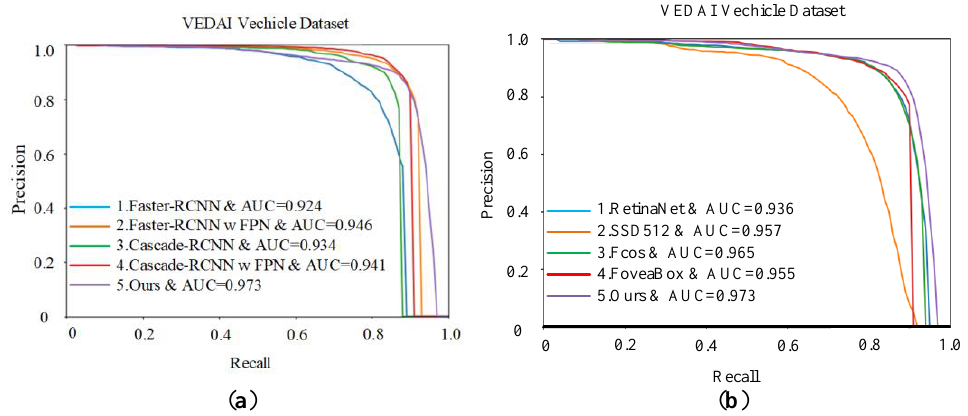
Figure 10. P – R curve of the VEDAI experiment: ( a ) two-stage, ( b ) single-stage. Figure 10. P–R curve of the VEDAI experiment: ( a ) two-stage, ( b ) single-stage. Figure 12. Detection results for VEDAI detection with the proposed method.